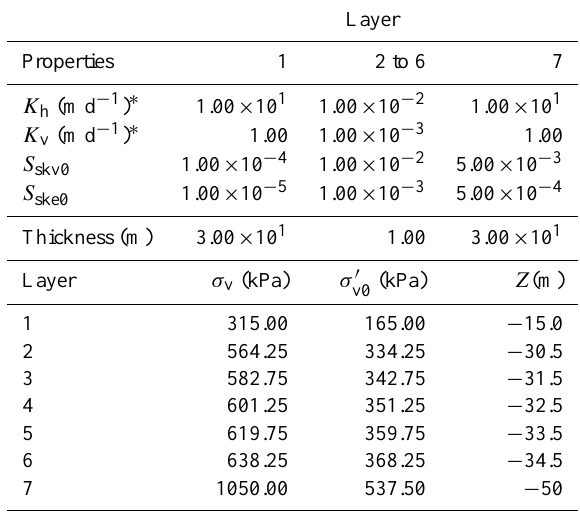
Figure 1. A conceptual model of an aquifer-aquitard system and the values of σ v and σ (cid:48) at different depths. v0 Table 1. Properties of the conceptual